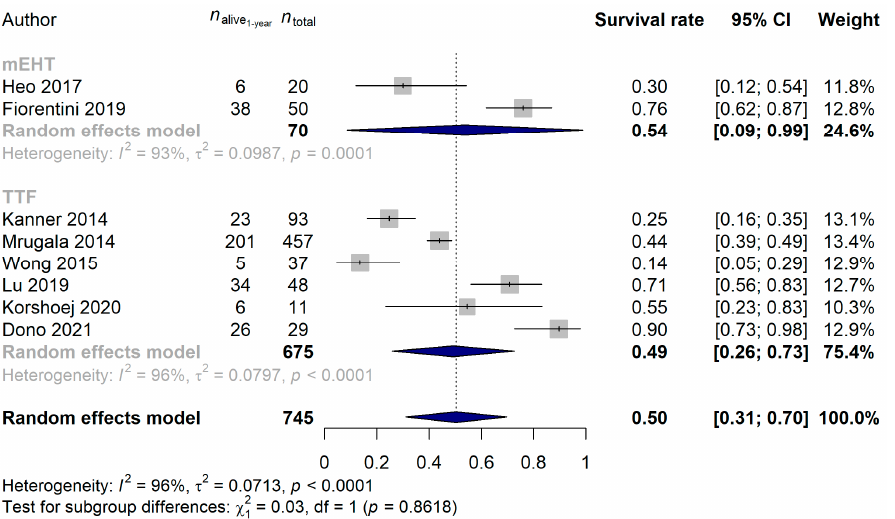
Figure 9. In newly diagnosed glioblastoma, the non-inferiority ( p = 0.4836) of modulated electro-hyperthermia (mEHT) could be observed compared with the more widely applied Tumor Treating Fields (TTF). It has to be noted that due to the wider acceptance of the Stupp protocol [10,71] and that patient survival significantly improved in the last decade [72], only the comparison of studies conducted after 2010 were compared [15,22,46,50,64,65,67,70].